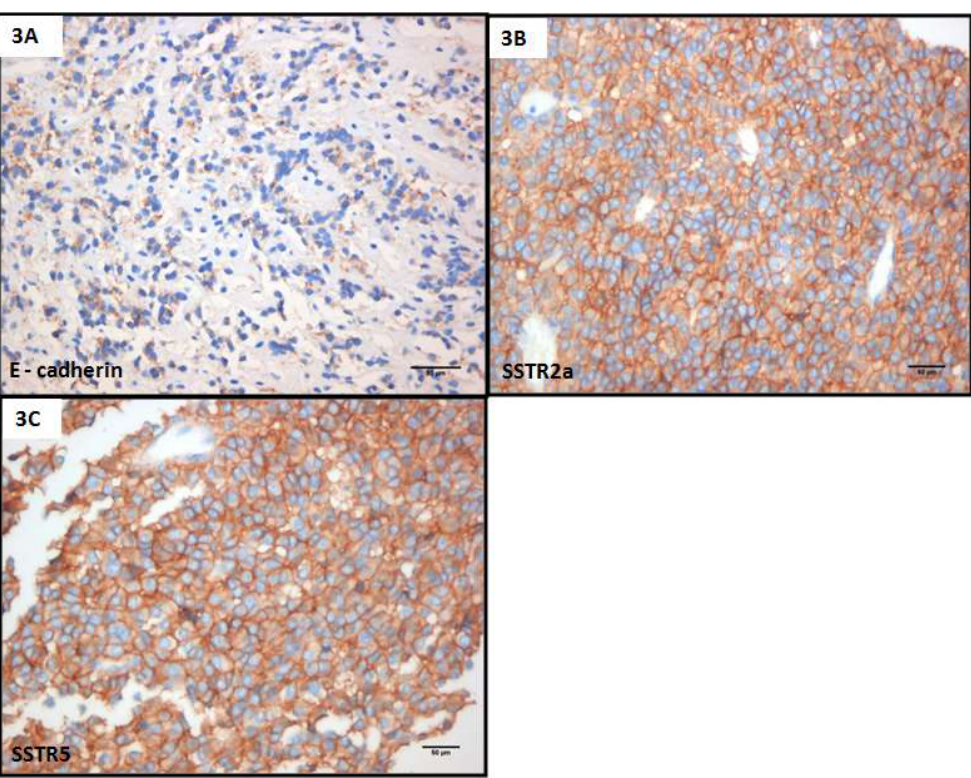
Figure 3. ( A ) Focally weak cytoplasmic expression of E-cadherin. ( B , C ) Circumferential membranous expression of SSTR2 and SSTR5, respectively, in more than 50% of the tumor cells, Volante score.